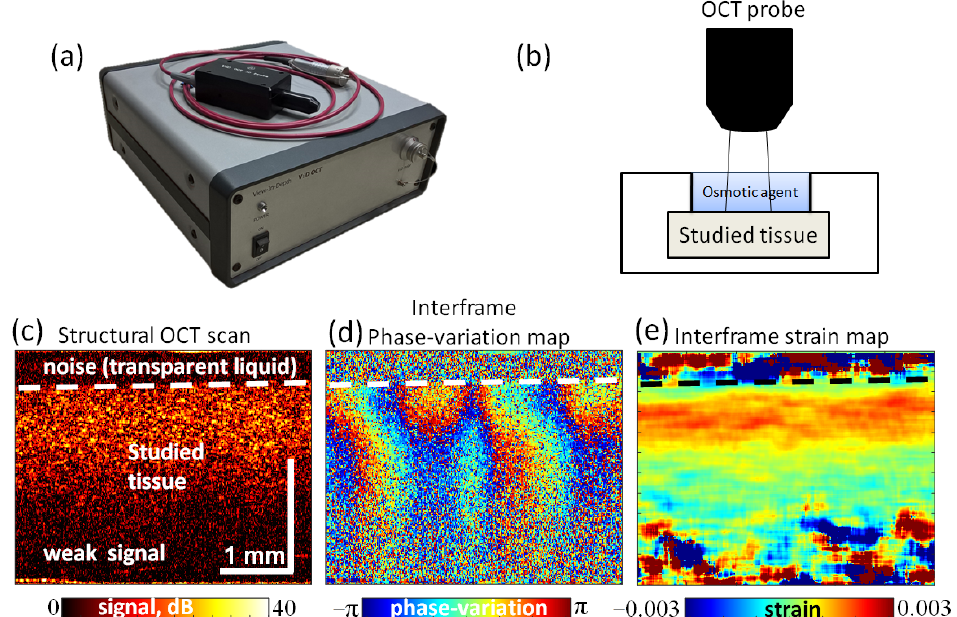
Figure 1. Schematically shown basic OCT block with a probe connected by a flexible fiber-optic cable ( a ); schematically shown tissue sample placed in protective plasticine shell with one side open ( b ); an example of a structural OCT scan ( c ); a color-coded map of interframe phase variation ( d ); and the derived map of interframe strains ( e ).